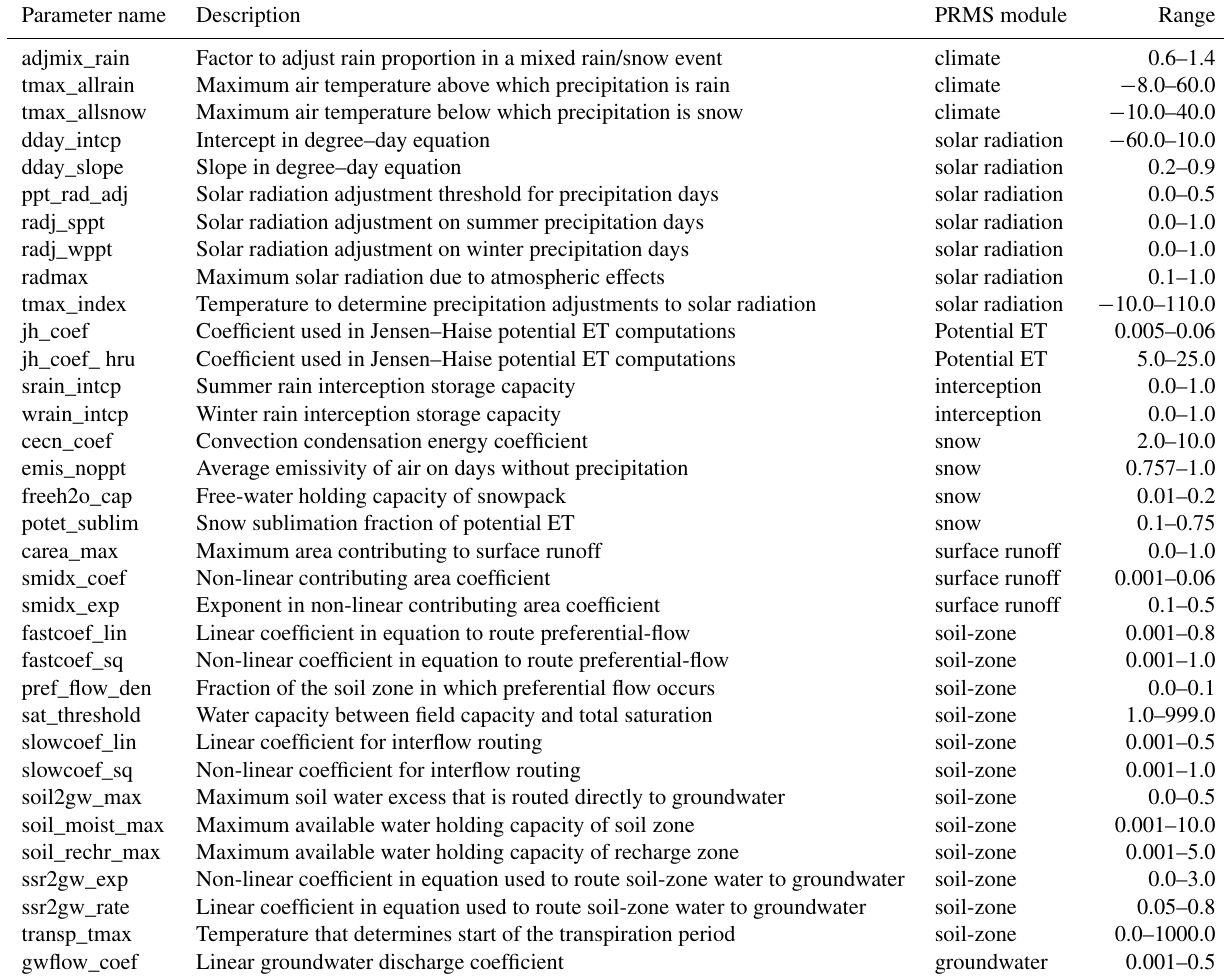
Table 1. Precipitation Runoff Modeling System (PRMS) calibration parameters used in this study. The values in the column labeled “PRMS module” identify the module type equation(s) from the PRMS source code (see Markstrom et al.,